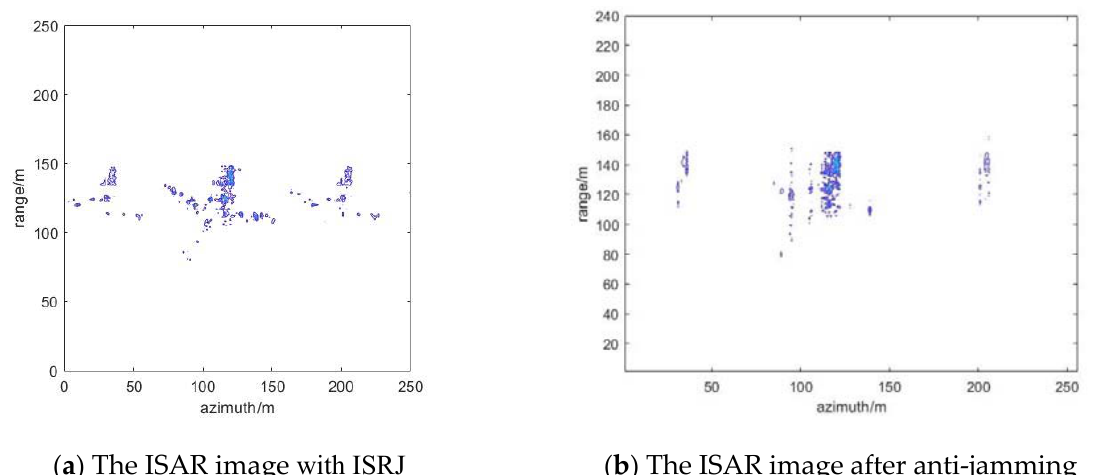
Figure 13. The results of ISRJ jamming and anti ‐ jamming in the fast time domain.